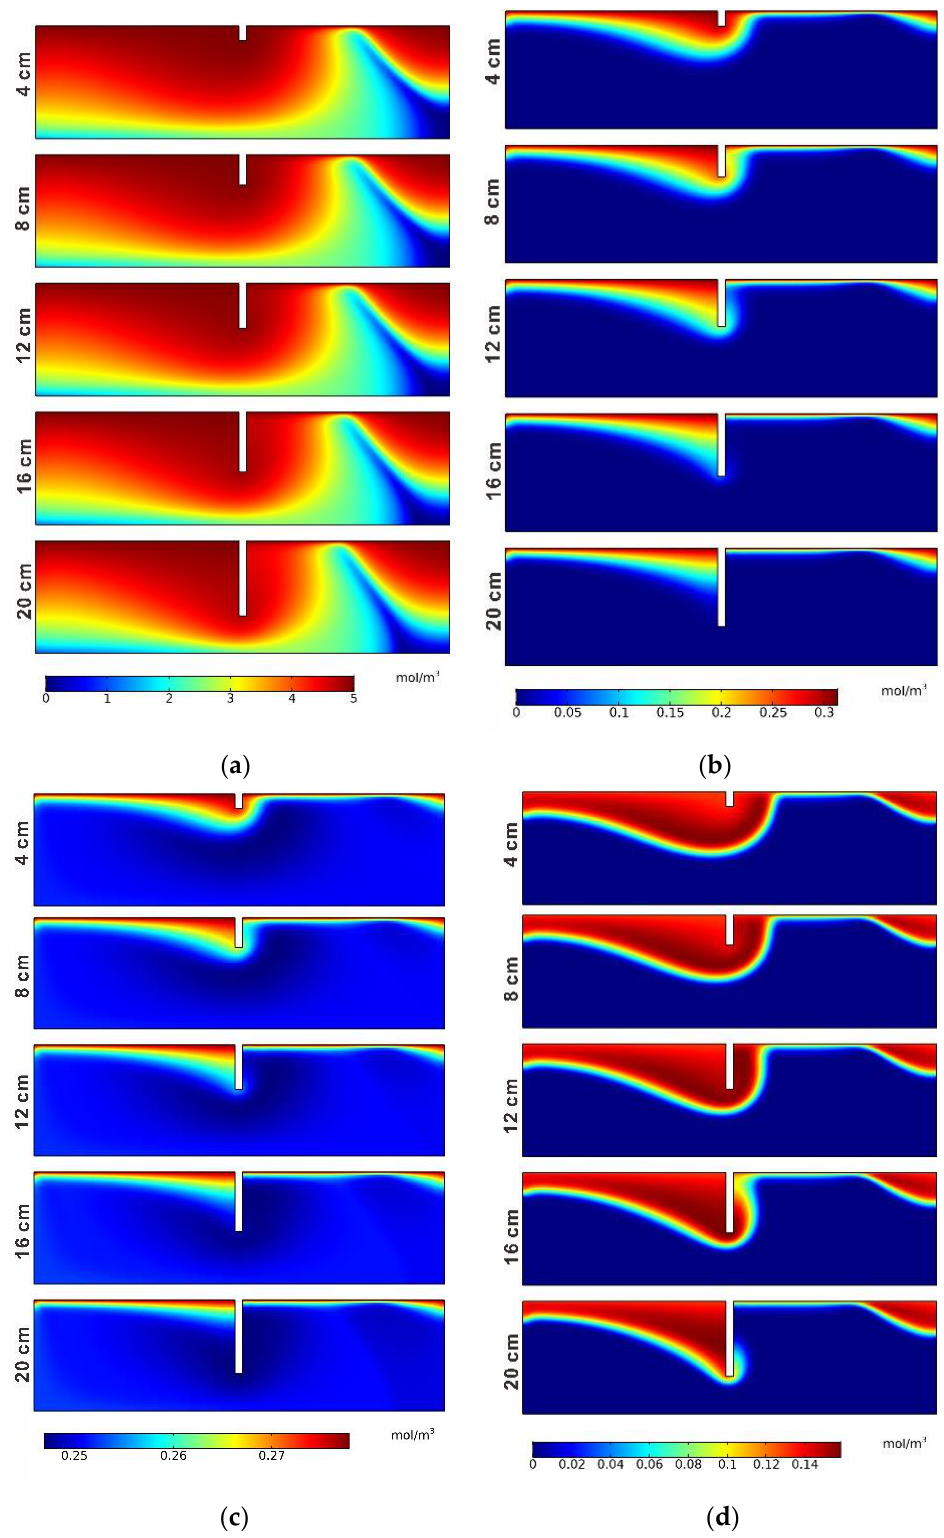
Figure 9. Concentration distributions of the four species in the five different burial depth cases: ( a )